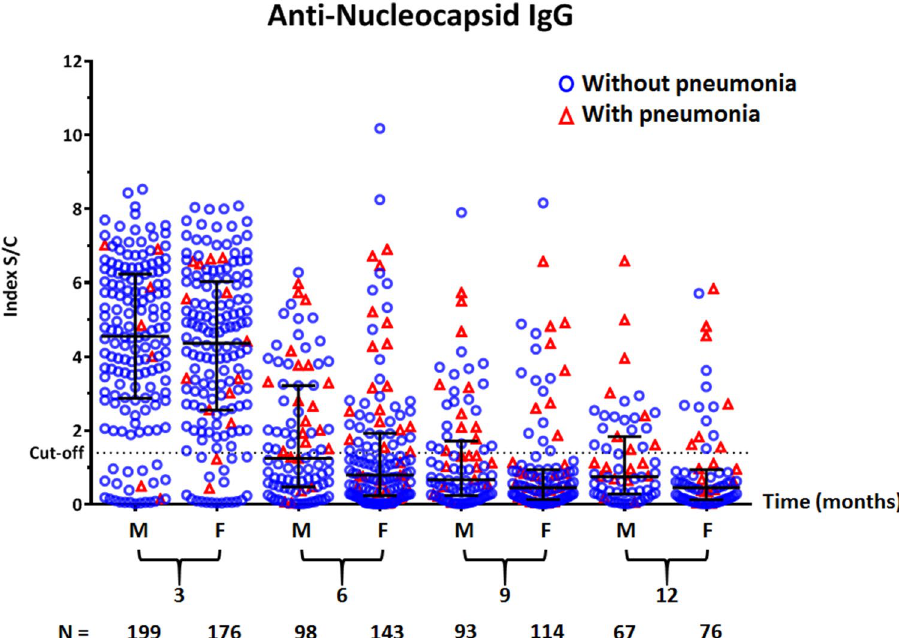
Figure 4. Scatter dot-plot with median and interquartile range (IQR) showing the distribution of anti- nucleocapsid IgG S/C index in serum samples of COVID-19 patients, stratified by sex ( F female, M male). Red triangles and blue circles represent patients with and without pneumonia symptoms, respectively.